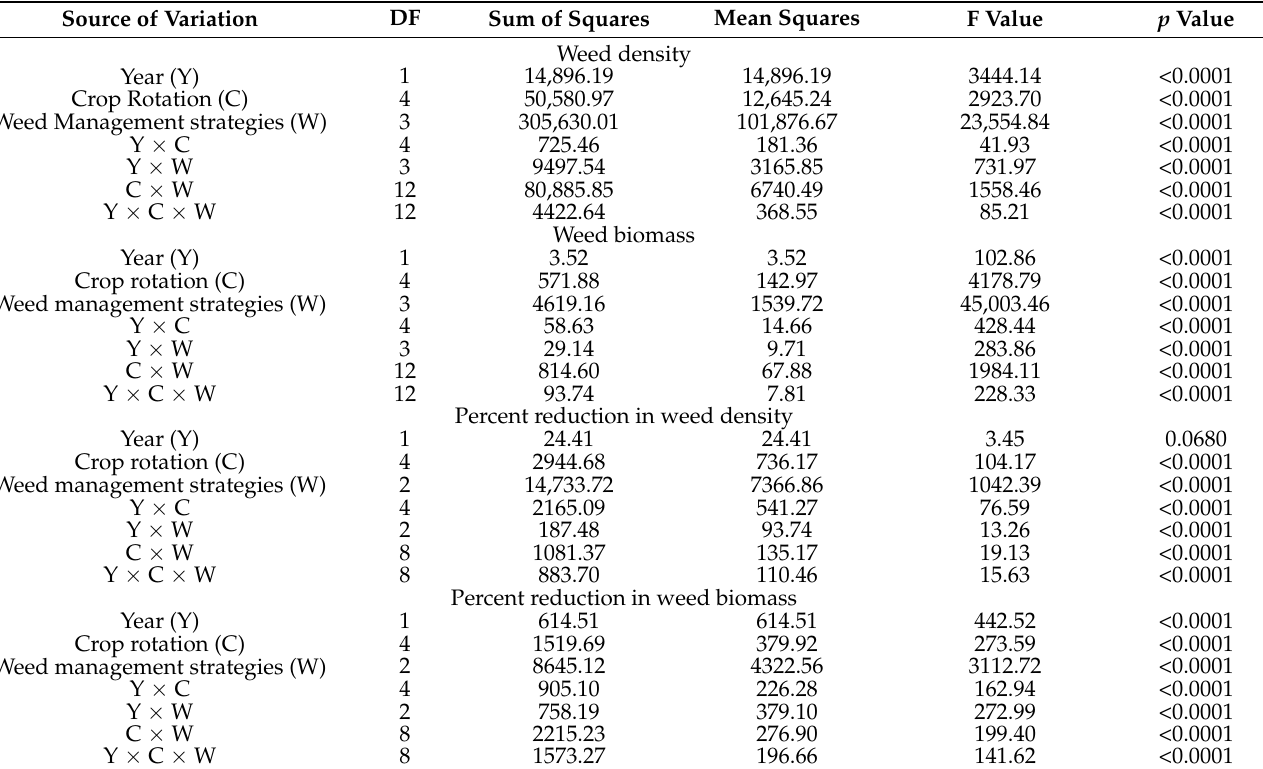
Table 5. Analysis of variance of weed density and biomass in wheat crop grown in different crop rotations under different weed management